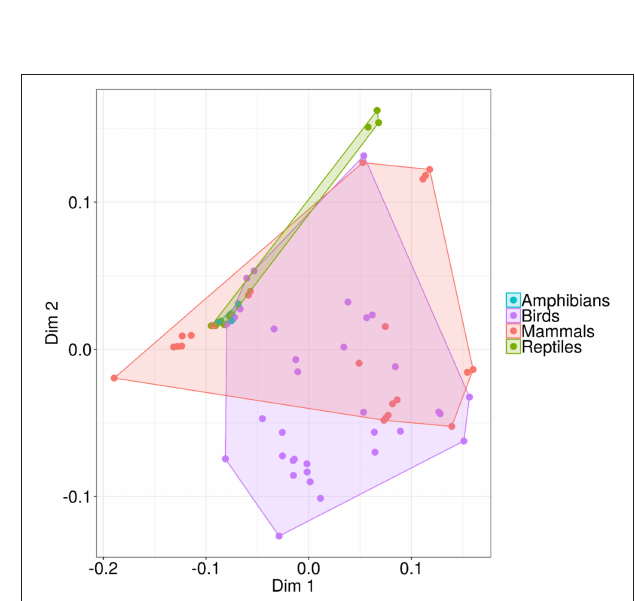
FIGURE 5 | Principal Coordinate Analysis (PCoA) performed on the trait matrix of killed species. The ordination shows the distribution of different species within trait space. Convex hulls, displayed in different colors, were calculated for each taxonomic class.